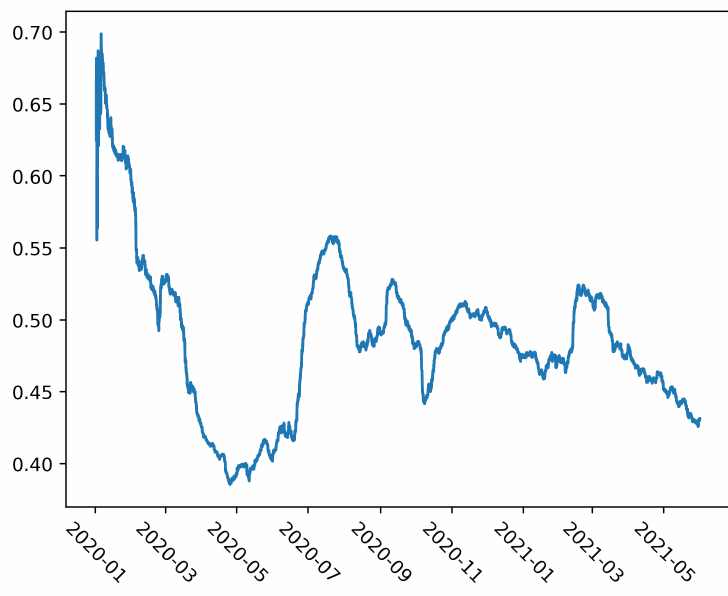
Figure 3. Sentiment (negativity) through time with a sliding window of 30 days. Positive direction on the y-axis represents negative